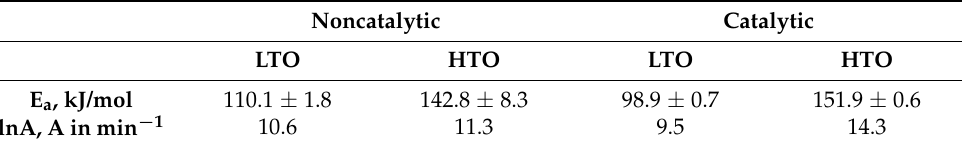
Figure 7. Kissinger plots for catalytic and noncatalytic oxidation for LTO ( A ) and HTO ( B ). Table 2. Arrhenius parameters of oxidation